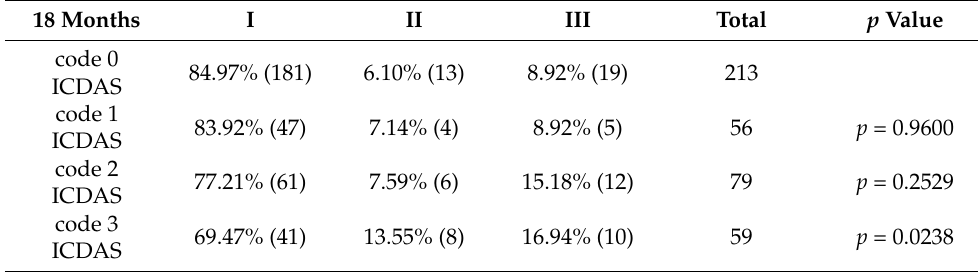
Table 4. Retention based on Simonsen’s criteria at the 18-month follow-up.